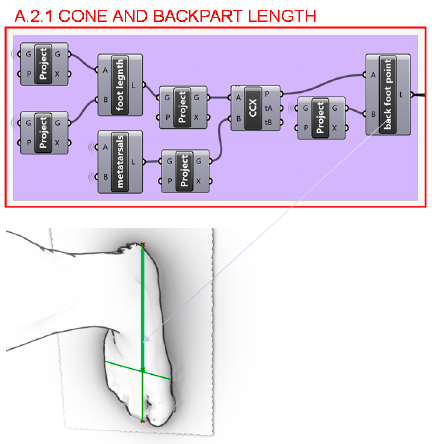
Figure 9. Programming structure definition to determine the length of waist and seat of the foot.